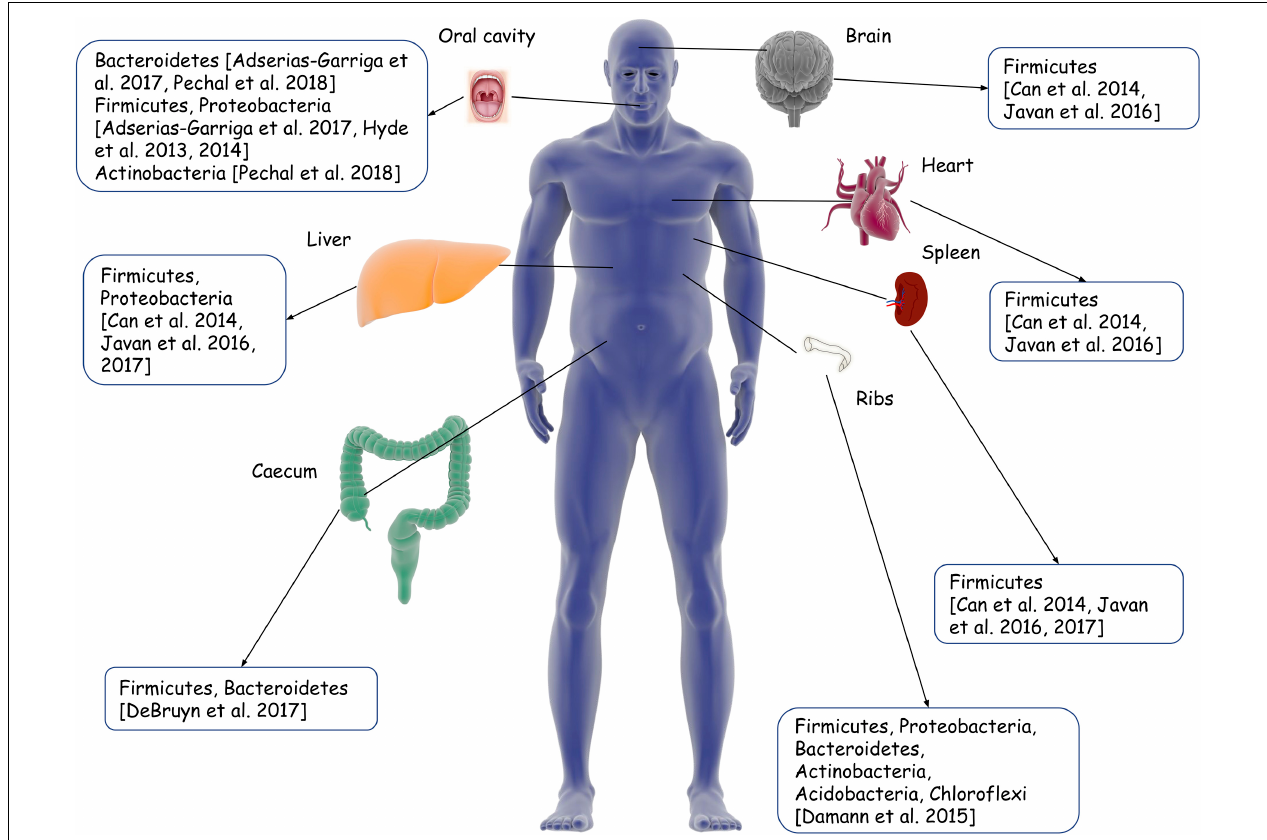
FIGURE 5 | Illustration of different body sites for thanatomicrobiome sampling from existing studies. Boxes indicate the dominant phyla in the microbial communities in that respective organ/body